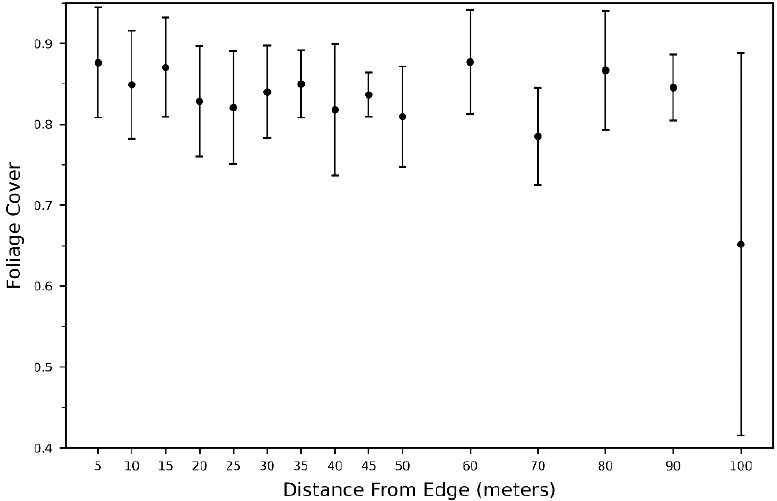
Figure 5. Average ground-based foliage cover (FC) for each sampled distance across all transects. Bars represent the 95% confidence interval around the mean. FC is shown as decimal percentages between 0 and 1 with 1 indicating 100% cover.